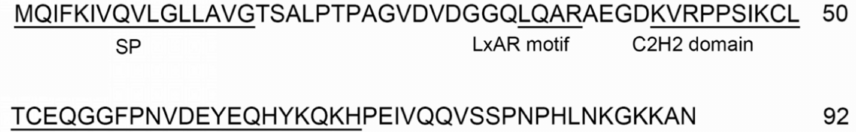
Figure 1. The conversed domain of Magnaporthe oryzae systemic defense trigger 1 (MoSDT1). Signal peptide (SP), LxAR motif and C 2 H 2 domain are underlined.